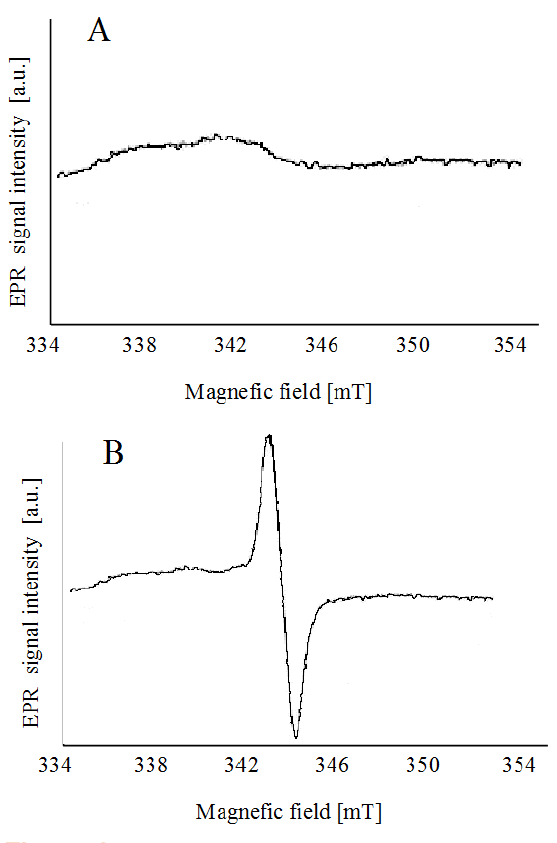
Figure 2. EPR spectra of pindolol before (A) and after (B) irradiation (400 kGy).